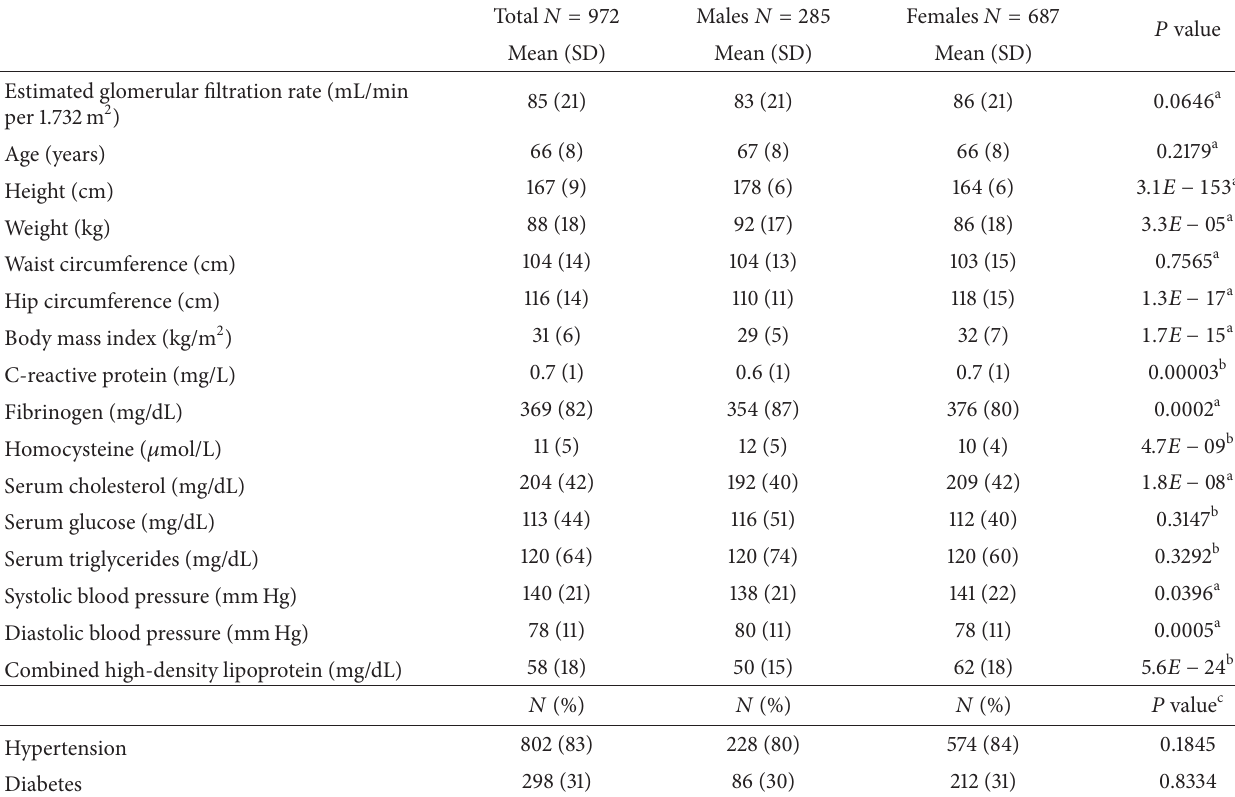
Table 1: Descriptive statistics of traits studied in GENOA African